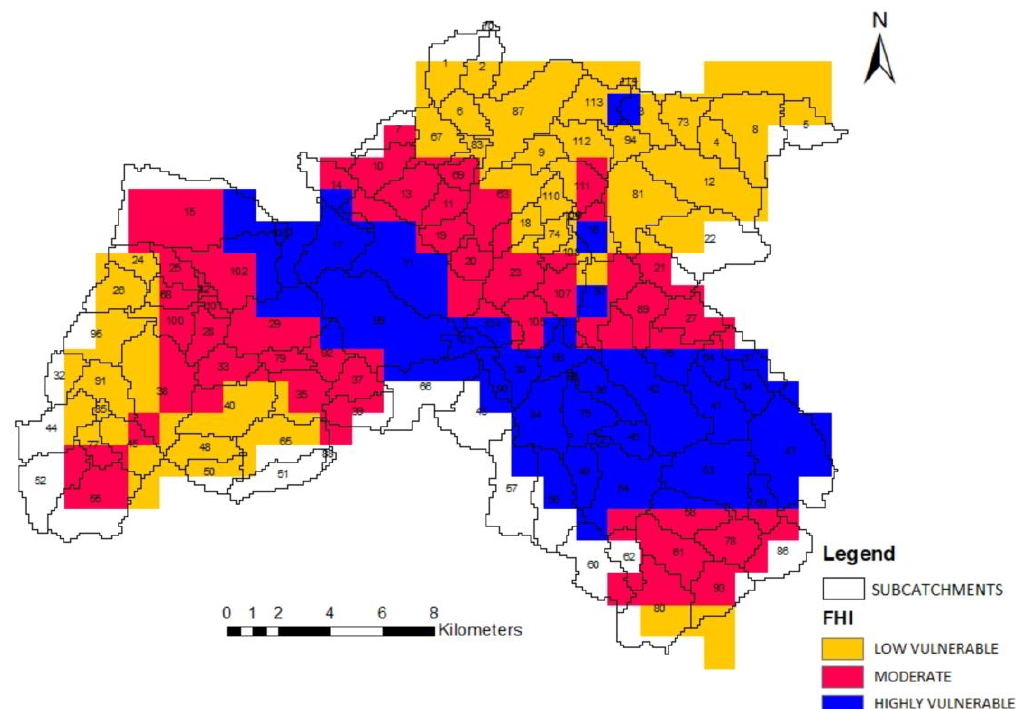
Fig. 13. Flood hazard map for the study